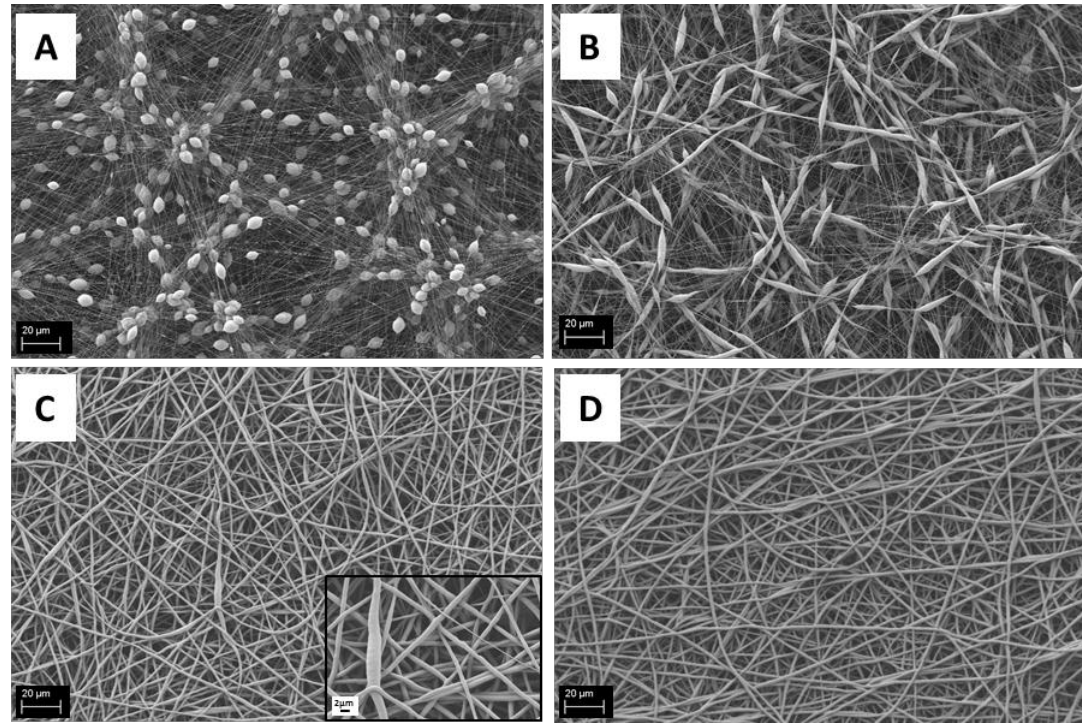
Figure 1. Scanning electron microscopy (SEM) micrographs of electrospun poly(epsilon-caprolactone) (PCL) mats obtained from different PCL solutions in acetic acid (scale bar 20 μm): ( A ) 12% w / v ; ( B ) 15% w / v ; ( C ) 18% w / v ; and ( D ) 20% w / v . Table 1. Summary of PCL fiber mats produced including sample name, fiber average diameter, and size of minimum and maximum fiber diameter measured on SEM micrographs (sample name: PCLsolutionconcentration_solvent_kV).